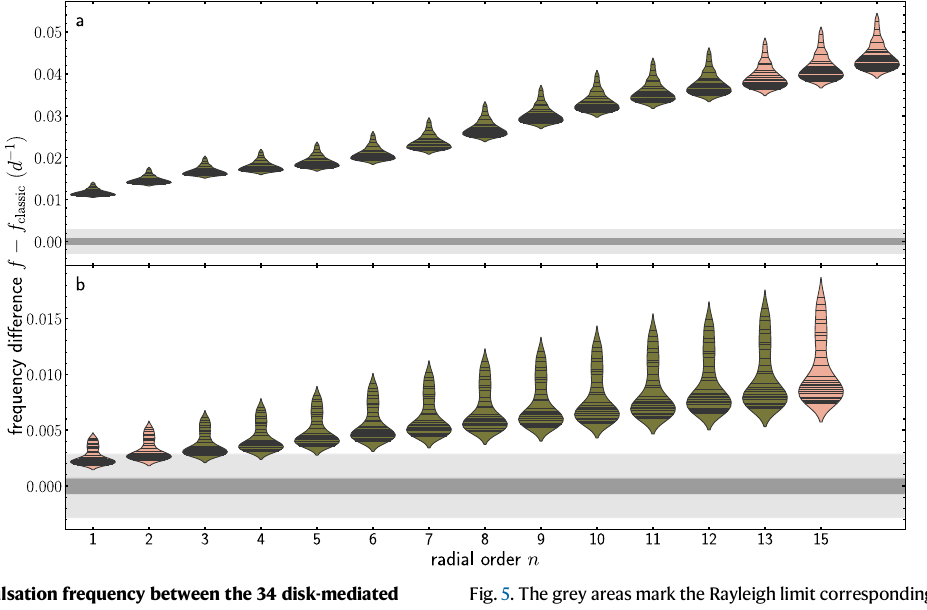
Fig.5. The grey areasmark the Rayleigh limitcorresponding to 4 yearKepler (dark grey)and357daysTESSlightcurves(lightgrey). a Resultsatthepre-mainsequence stage. b Results at the